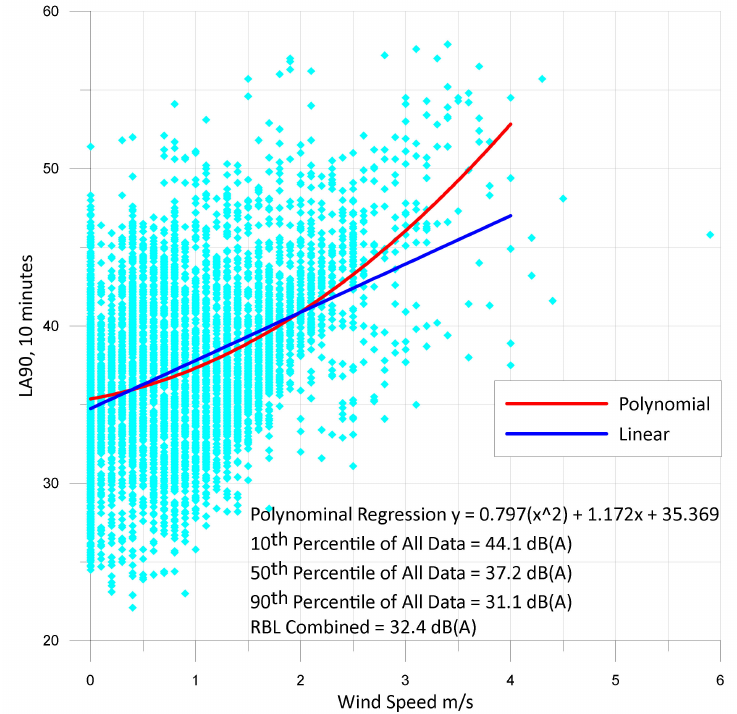
Figure 15. Waubra Wind Farm Regression for NW Wind Quadrant—Post Construction Test, Microphone and wind at 1.5 m